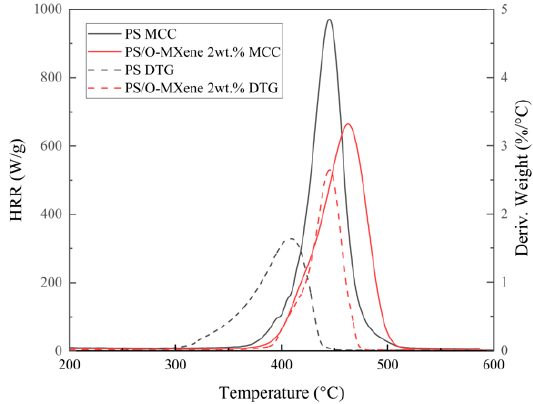
Figure 5. PCFC HRR vs. DTG curves of PS and PS/O-Ti 3 C 2 nanocomposites.